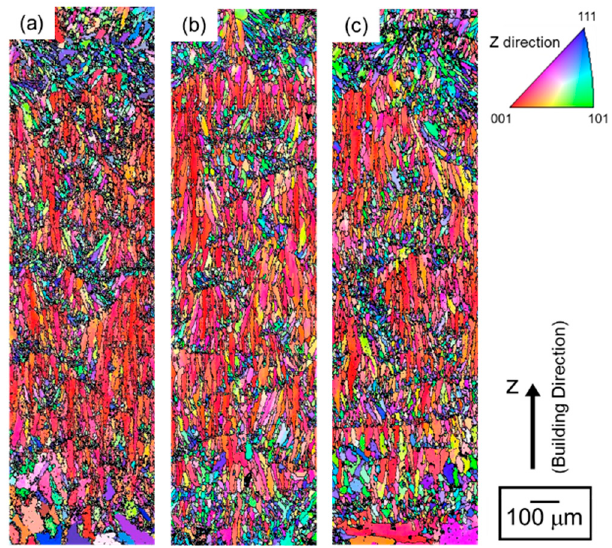
Figure 7. Orientation distribution maps of the node portion of the lattice specimen: ( a ) as-manufactured, ( b ) annealed at 300 ◦ C for 2 h, and ( c ) solution heat treated at 530 ◦ C for 6